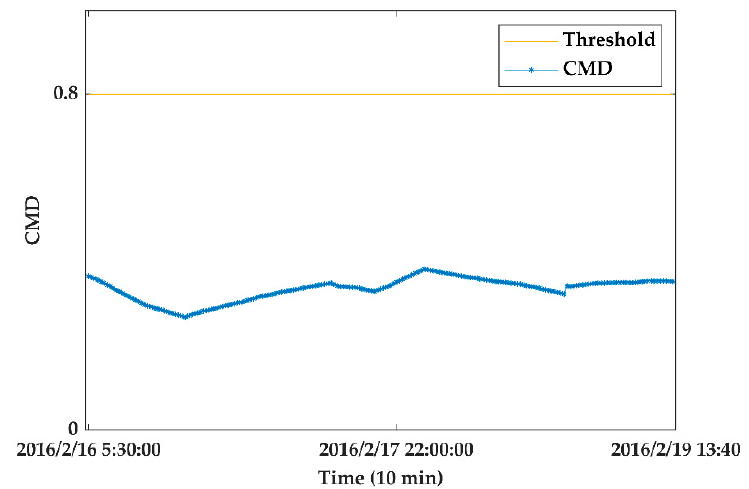
Figure 13. The change curve of CMD of hydropower unit after maintenance was completed in case 1.